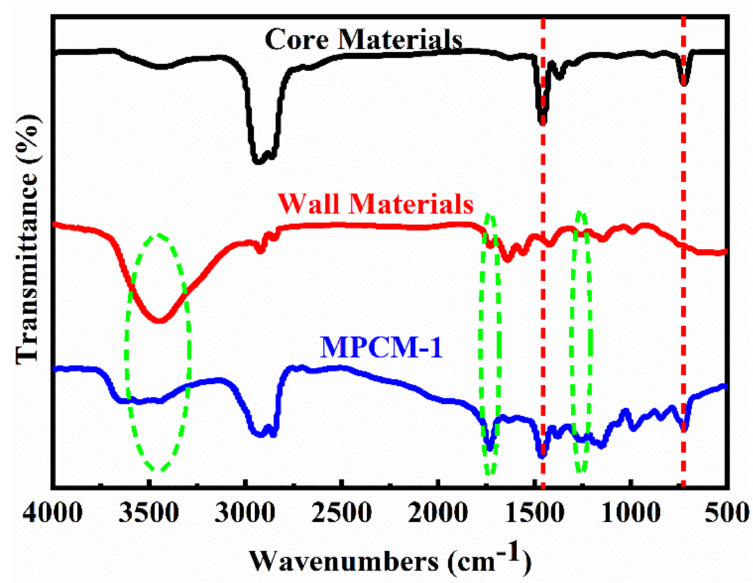
Figure 4. FTIR spectra of core materials (PCM), wall material (WM), and MPCM-1.